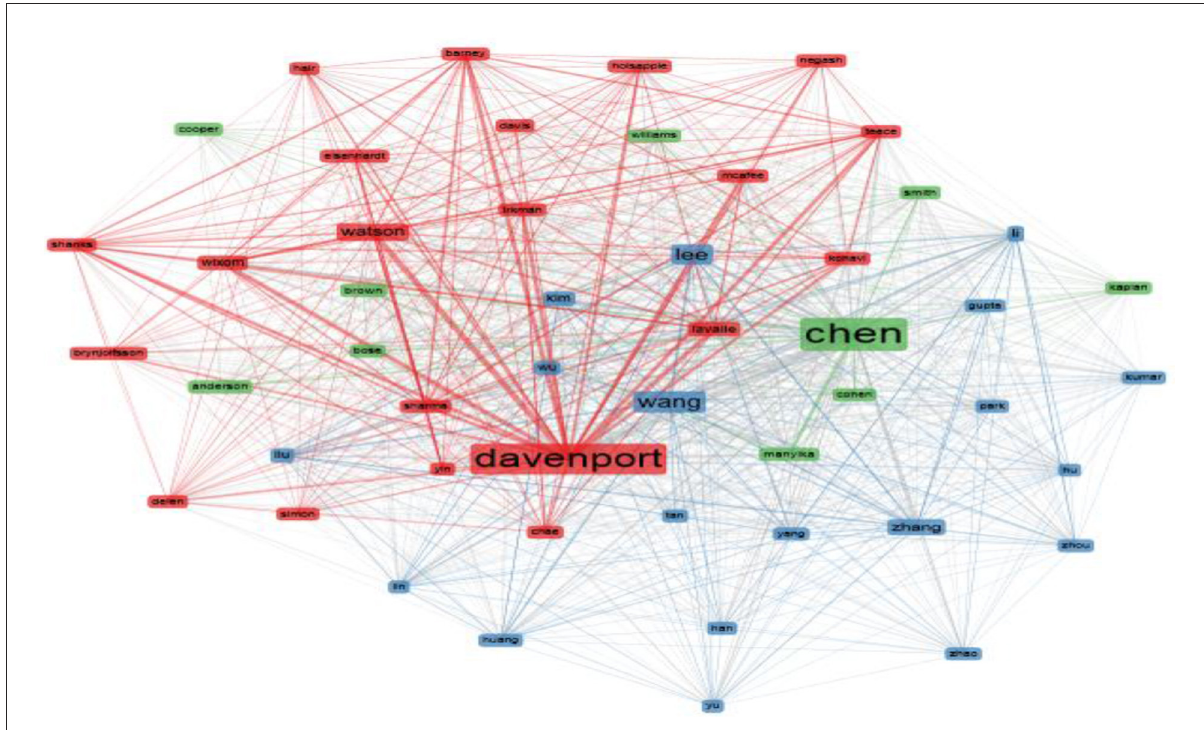
FIGURE13 Co-citation networks. Source: Own elaboration using